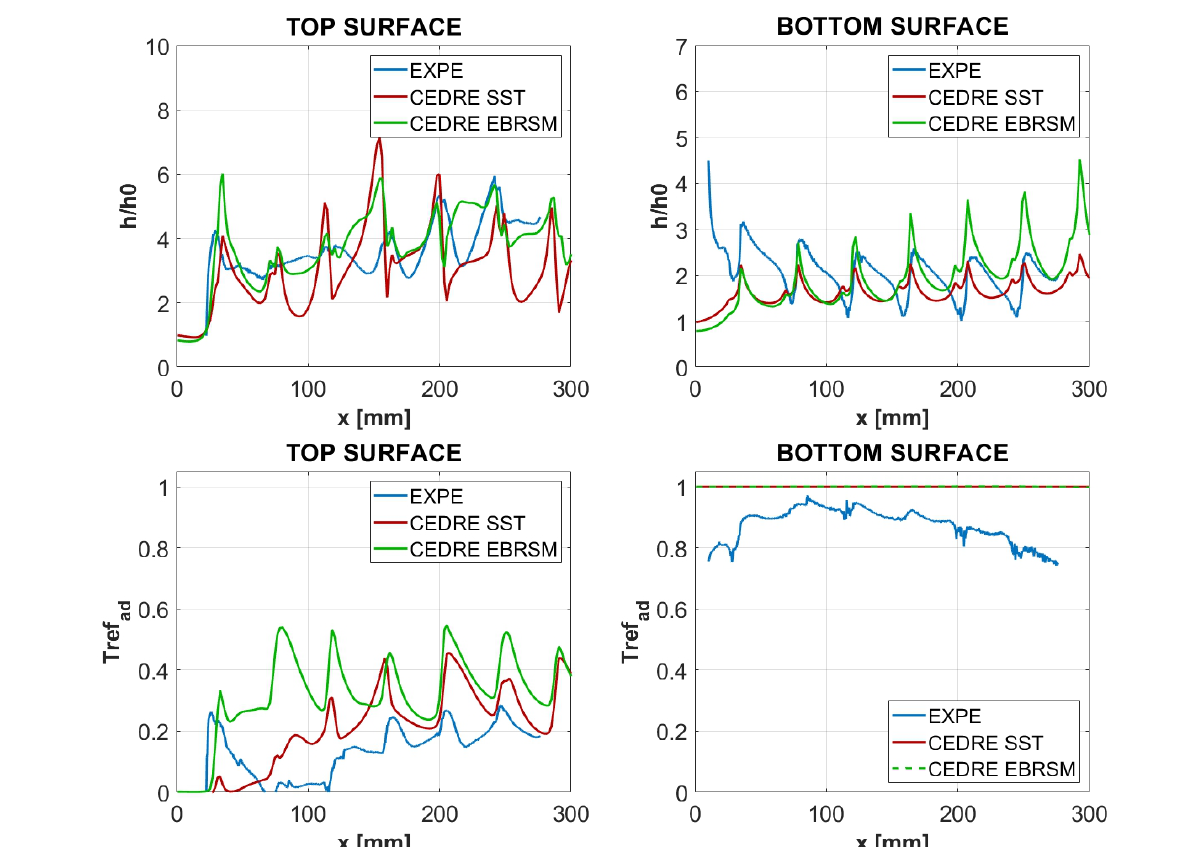
Figure 27. Comparison of laterally averaged HTC and adiabatic